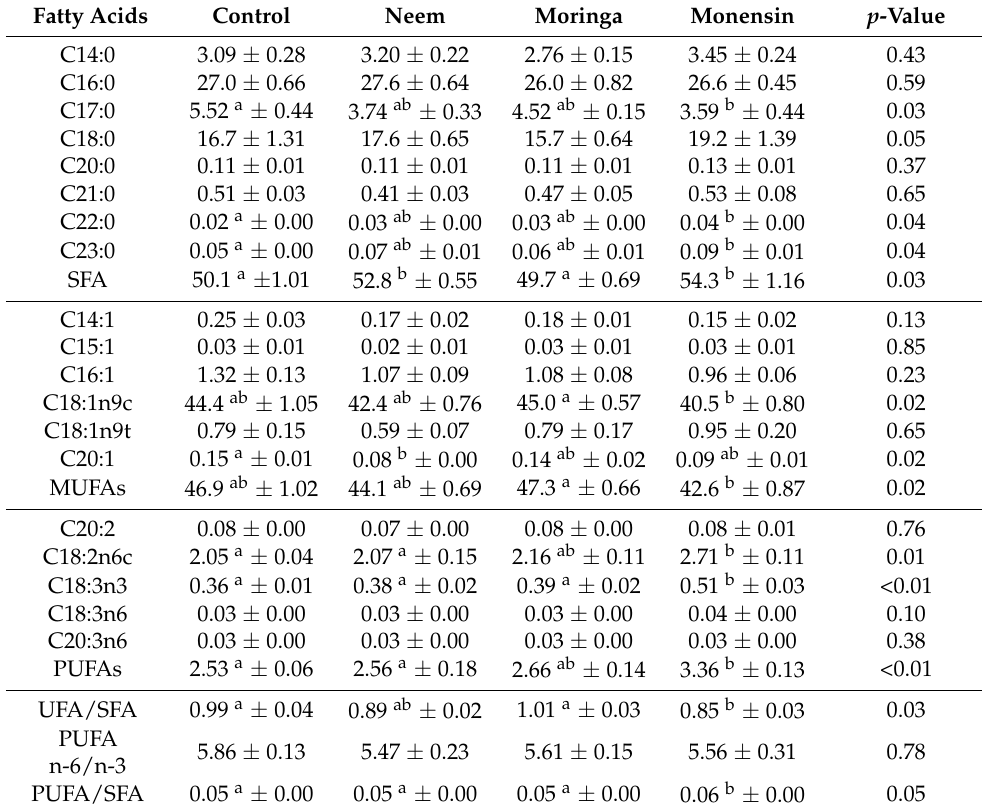
Table 4. The effects of dietary inclusion of Azadirachta indica and Moringa oleifera leaf extract on the fatty acid composition of the subcutaneous fat (w/w%; LS mean ± SE) of South African Mutton Merino